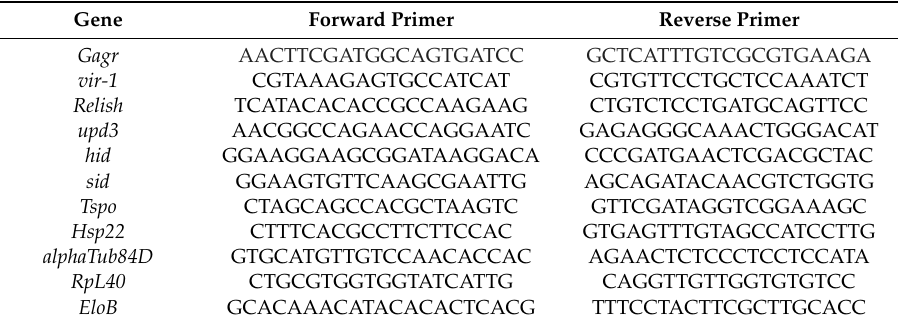
Table 2. Primers used in quantitative PCR